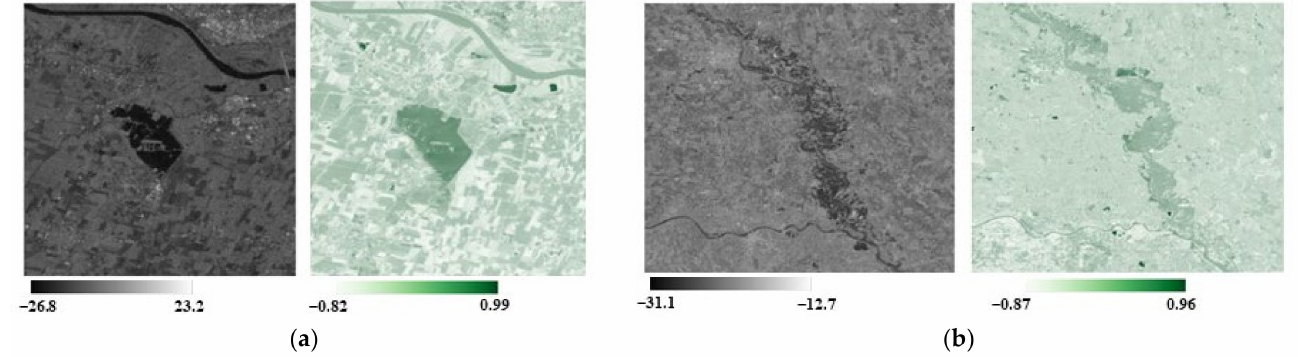
Figure 3. VV-derived SAR backscatter ( left ) and NDWI ( right ) images for the events in ( a ) 2017 and